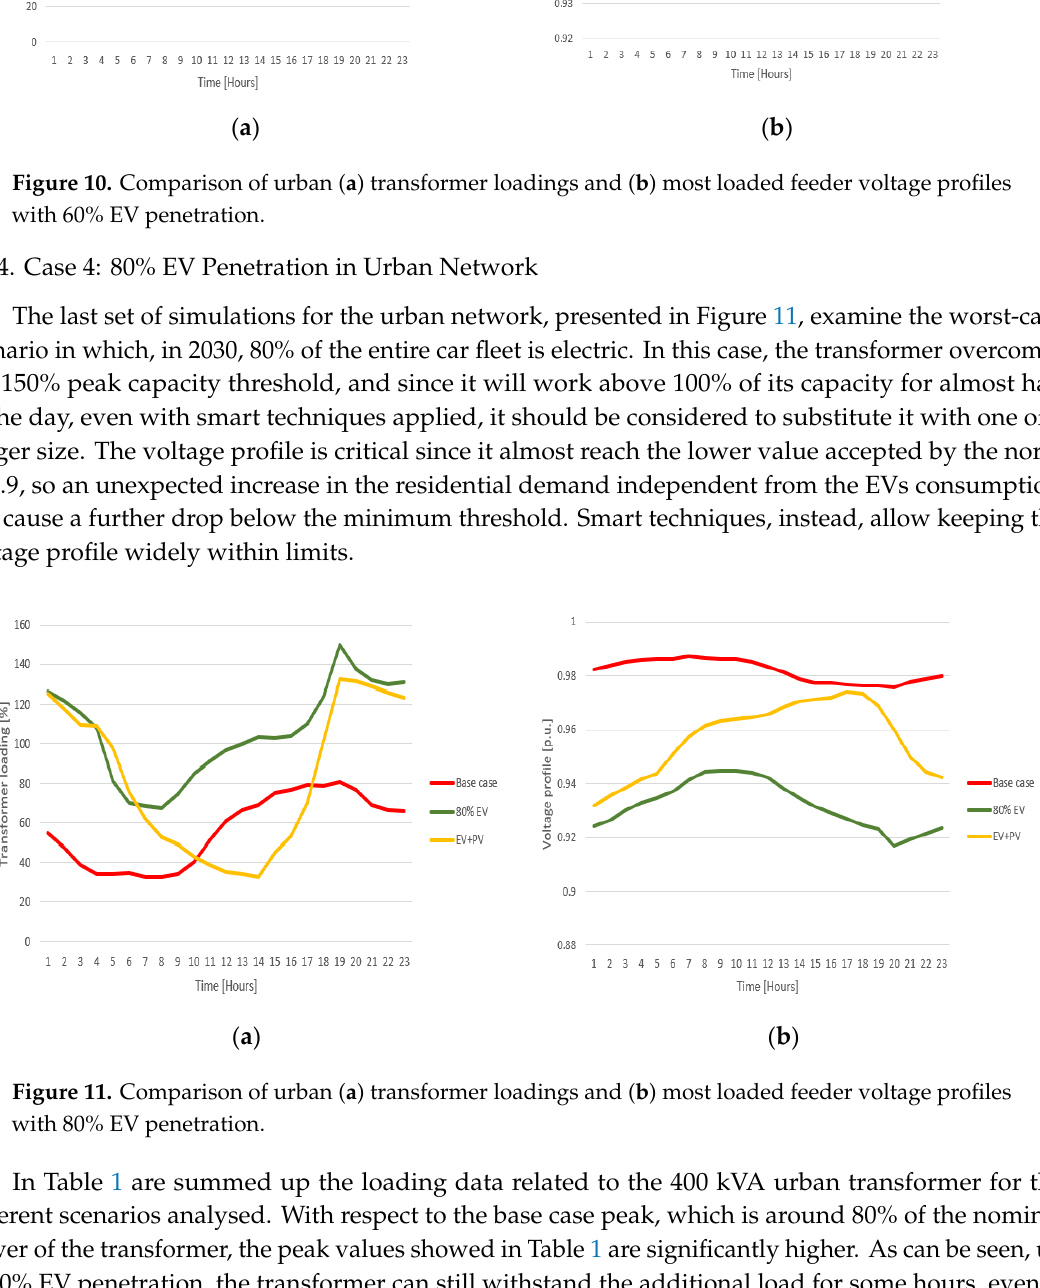
Table 1. Urban transformer loading data.